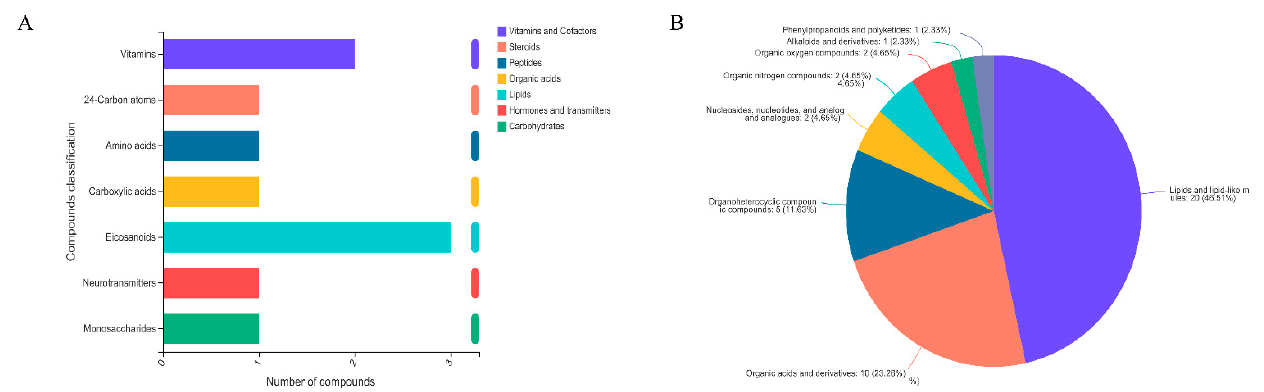
Figure 7. Classification analysis of differential metabolites based on KEGG database ( A ) and HMDB database ( B ). database ( B ).